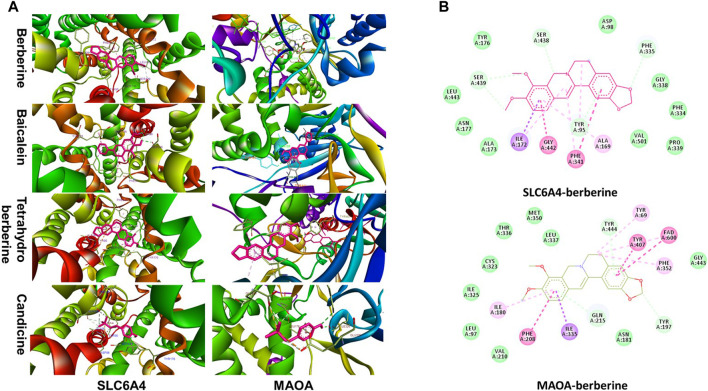

(A) Stereoview of substrate/inhibitor binding of SLC6A4 and MAOA with berberine, baicalein, tetrahydroberberine, and candicine; (B) Biding poses of berberine at SLC6A4 and MAOA binding sites.